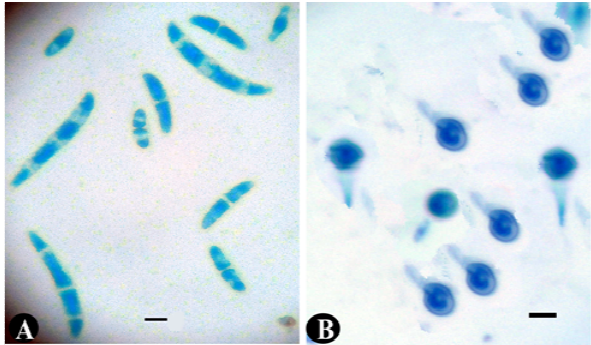
Fig. 2b. Fusarium oxysorum G30 (Scale = 10 µm): microspores; B. Chlamydospores